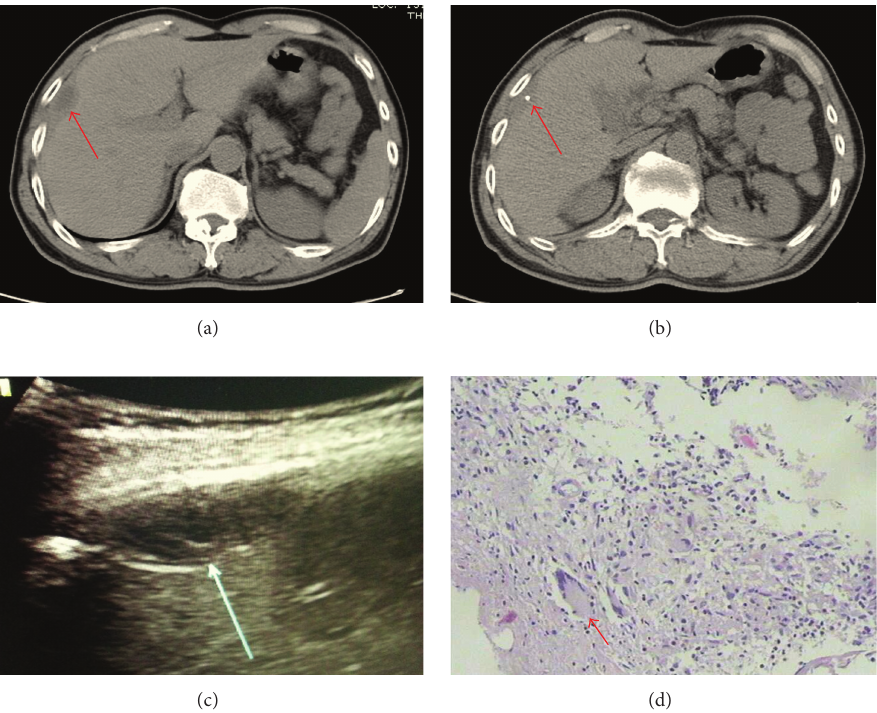
Figure 6: Abdominal CT, ultrasonography, and cytohistological features on H&E-stained specimens for localised tuberculous peritonitis. (a), (b) Abdominal CT and (c) ultrasonography demonstrated a hepatic lesion (arrows). (d) Cytohistological features of the liver biopsy on H&E-stained specimens display the presence of Langhans cells (red